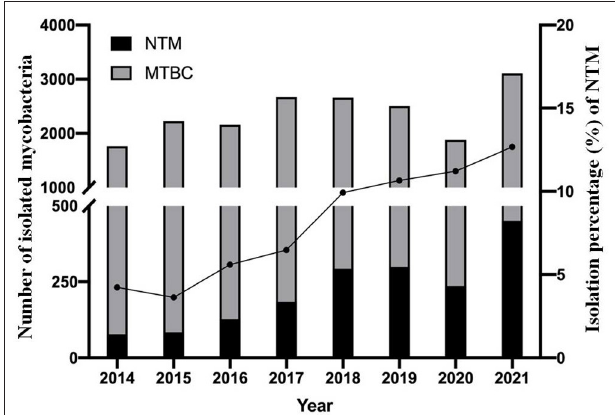
FIGURE 1 | Continued upward trend in the proportion of NTM isolates over the 8-year study period. Filled circles (•) denote the percentage of NTM isolates each year. MTBC, mycobacterium tuberculosis complex; NTM, non-tuberculous mycobacteria.